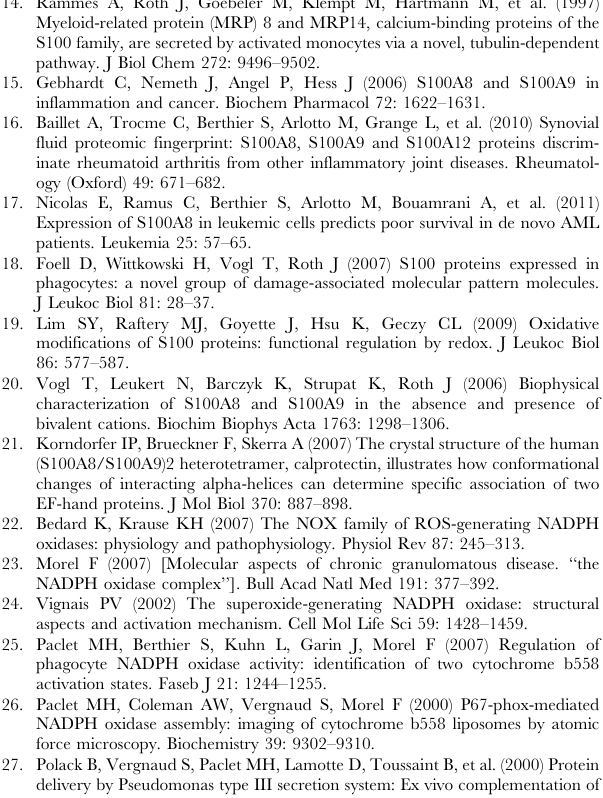
active cytochrome b 558 from heparin agarose matrix procedure. Cytochrome b 558 was extracted with 2% (w/v) octyl- glucoside from the membrane of stimulated human neutrophils as described in Materials and Methods. Proteins of the soluble extract were loaded onto a mixture of CM, DEAE, and n-amino-octyl Sepharose combined to heparin agarose. Cytochrome b 558 bound to the heparin affinity matrix. The matrix was extensively washed with either rS100A9-A8 chimera or with cytosol of stimulated EBV-B lymphocytes. The cytochrome b 558 containing fractions eluted from heparin agarose were pooled and filtrated on S-300 Sephacryl. Purified cytochrome b 558 recovered from Sephacryl displayed a constitutive NADPH oxidase activity. Figure S2 Purification and identification of rHis- S100A12. (A) Recombinant rHis–S100A12 was affinity purified from the 100,000 g supernatant of IPTG induced BL21 (DE3) E. Coli lysis medium as described in Materials and Methods. U stands for the 100,000 g supernatant; E1 to E4 are the 300 mM imidazole eluted fractions from the Talon matrix. Proteins of samples U and E were fractionated by 15% SDS-PAGE and stained with Coomassie Blue. (B) rHis-S100A12 proteins were identified by Coomassie bleu staining and by Western blot with a